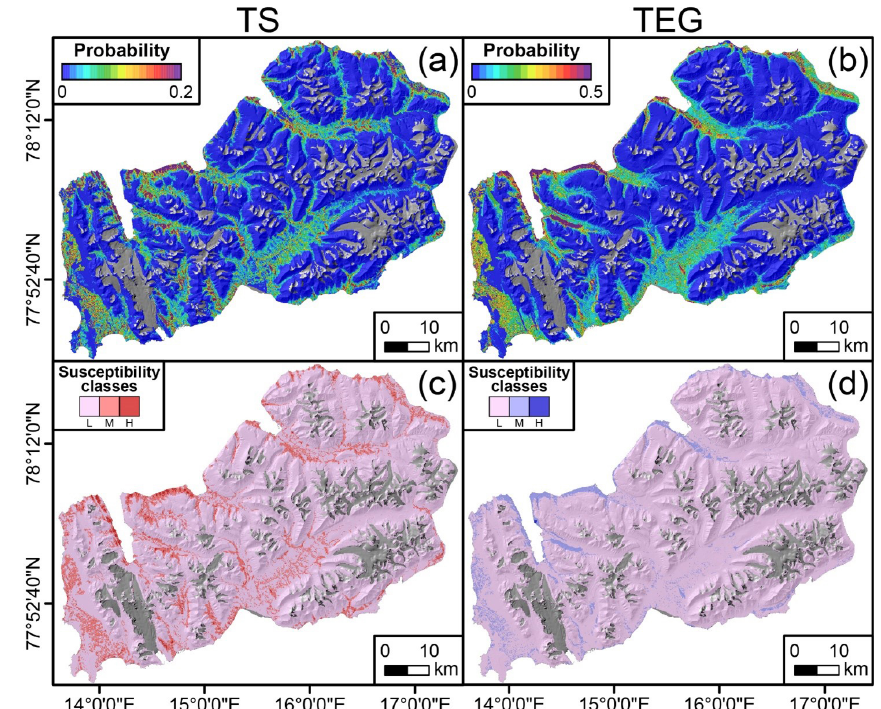
Figure 7. Susceptibility map reporting the probability in its continuous (a, b) and classified (c, d) forms for TSs (a, c) and TEGs (b, d) , respectively. Grey areas correspond to glaciers which have been masked out from the analyses. The classification followed the Jenks method by minimising the within-class variance after an arbitrary choice of three classes (L for low, M for medium, and H for high susceptibility).